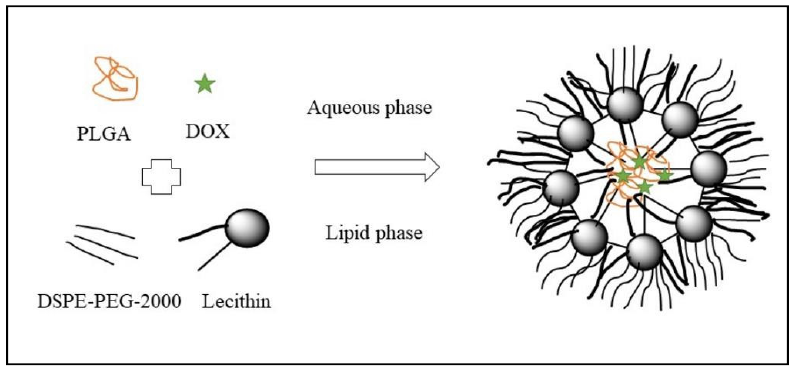
Figure 4. Schematic diagram of the DOX NPs (Reproduced from open access journal under the terms of creative commons attributes)